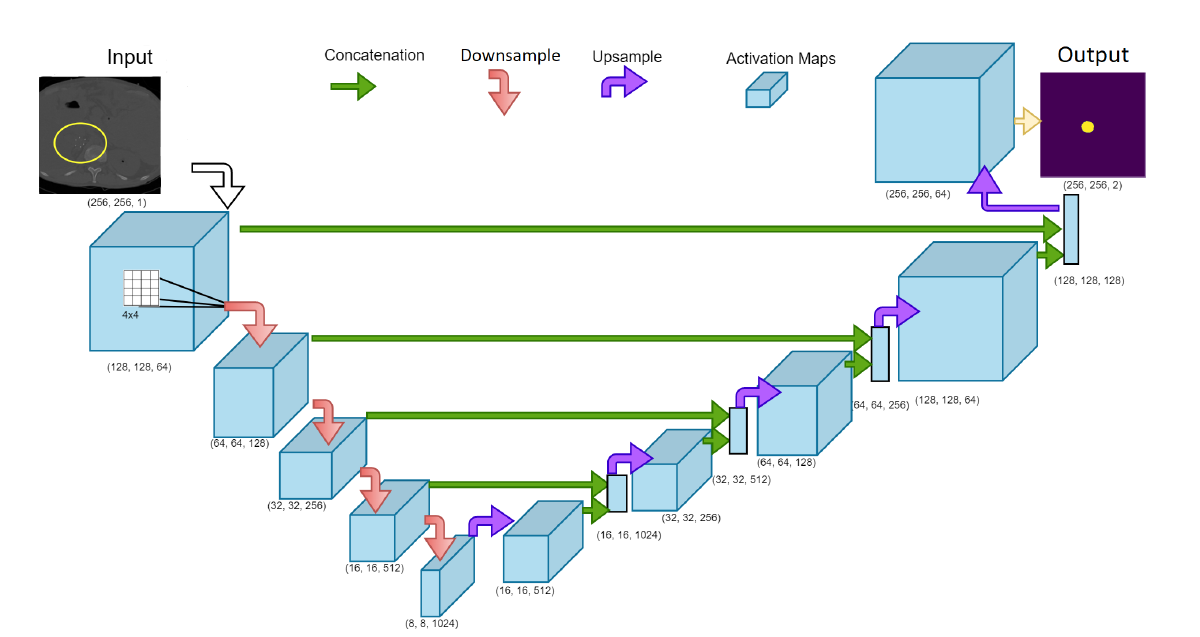
Figure 6. UNet model architecture used for the training phase to generate a segmented map of the IVCF in the CT image slices. The downsampling and upsampling phase were evaluated as separate functions and called using the gradient tape function in TensorFlow. Numbers indicate the (width, height, kernels) used in the layer. Arrows indicate the operation performed while